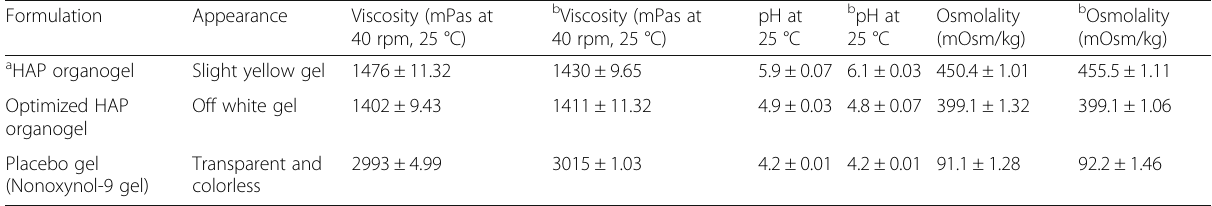
Table 7 Physicochemical characterization of the formulations Formulation